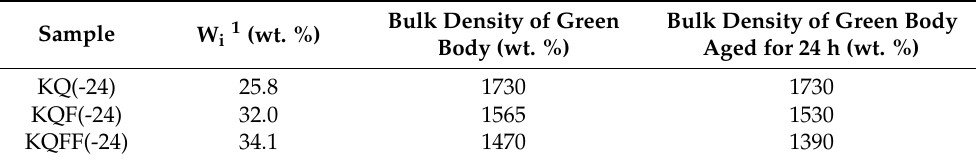
Table 4. Properties of dried green samples.